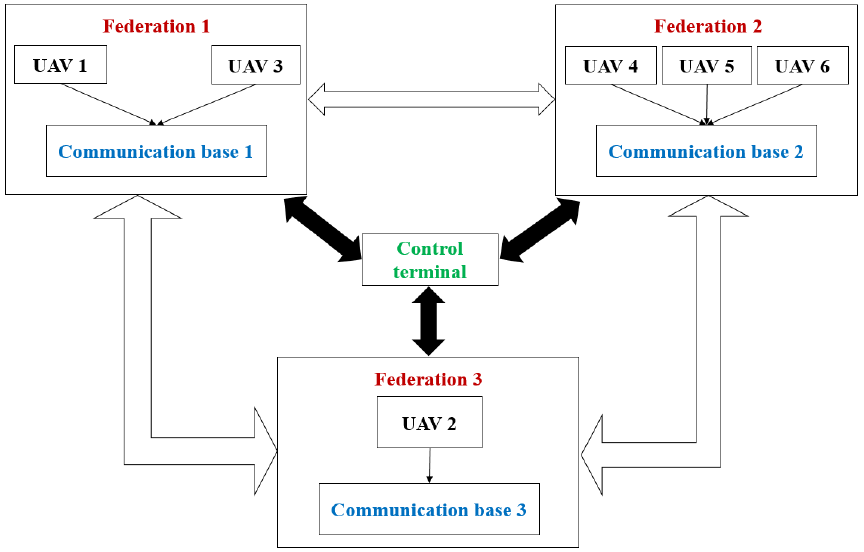
Figure 20. Agent formation in pesticide spraying mission.